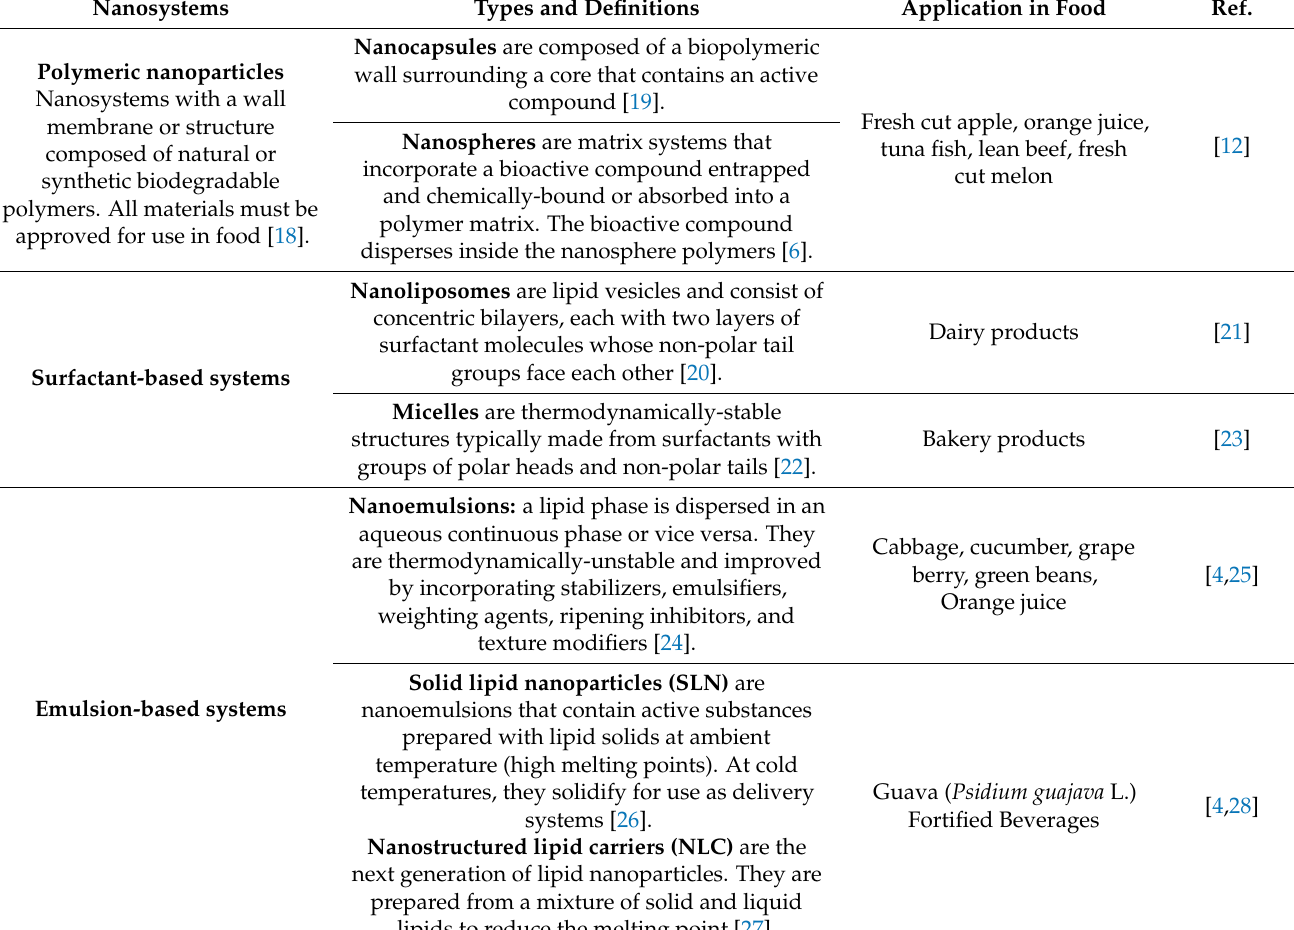
Table 1. Nanosystems applied in food